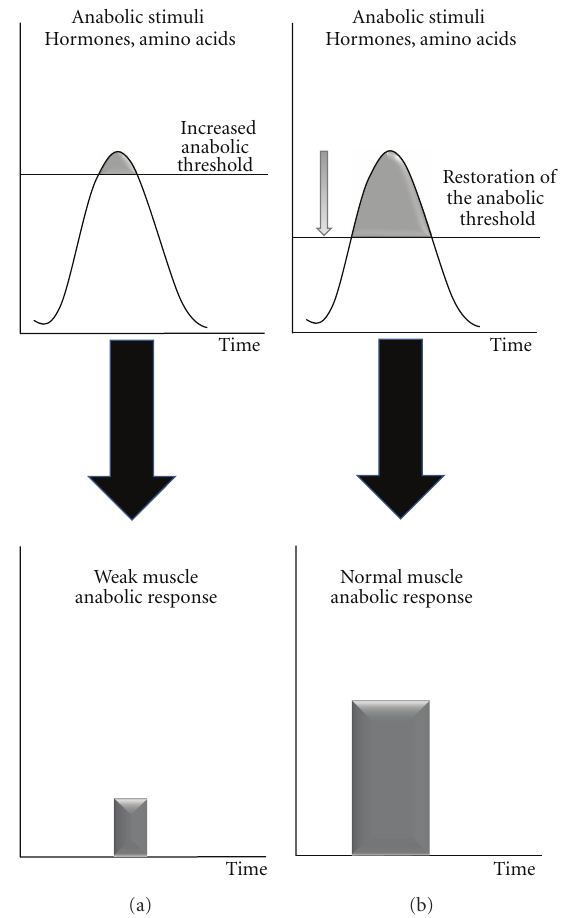
Figure 3: Strategies aiming at partially decreasing the muscle “anabolic threshold” and increasing the e ffi ciency of the postprandial